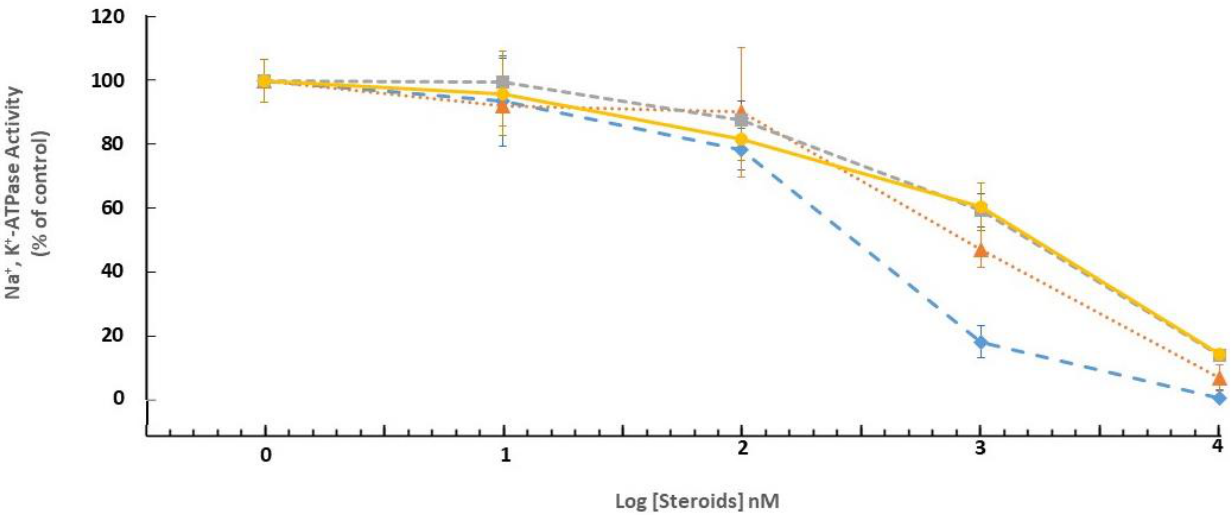
Figure 8. Effect of bufalin, bufalin 2,3-ene, and bufalin 3,4-ene on human cancer and non-cancer cell growth. A549, alveolar basal epithelia cell carcinoma ( A ), HCT 116, colorectal carcinoma ( B ), U-251, glioblastoma ( C ), HaCaT, immortalized keratinocytes ( D ), and HFF-1, fibroblasts ( E ) cell lines were grown as described in Materials and Methods. The cells were incubated in growth media containing different concentrations of bufalin (green, ▲ ), bufalin 2,3-ene (red, ●) , or bufalin 3,4-ene (blue, ■ ) for 48 h. At the end of incubation period, cell viability was determined as described in Materials and Methods. Percentage of cell viability was calculated using the formula: (fluorescence of treated cells